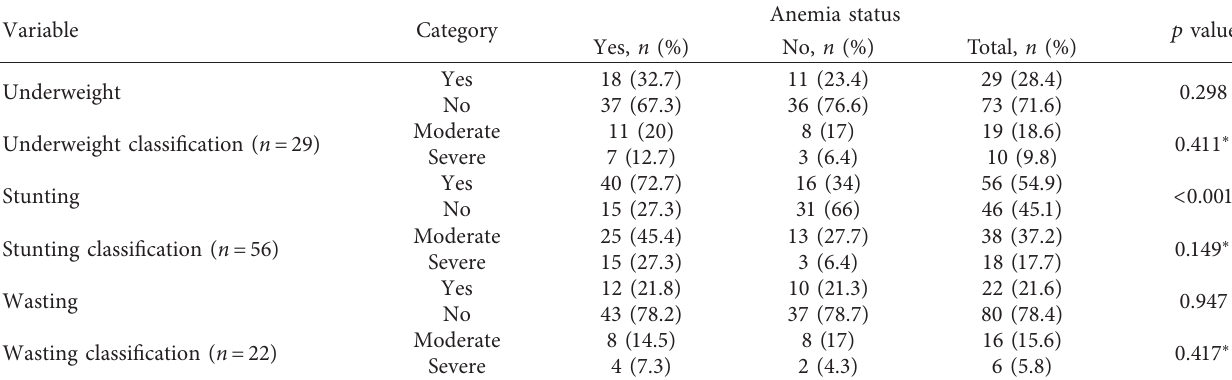
Table 2: Pre-ARTnutritional status of study participants by anemia status of HIV-infected children aged 6 months to 15 years, in the Afar region, Ethiopia, 2018.